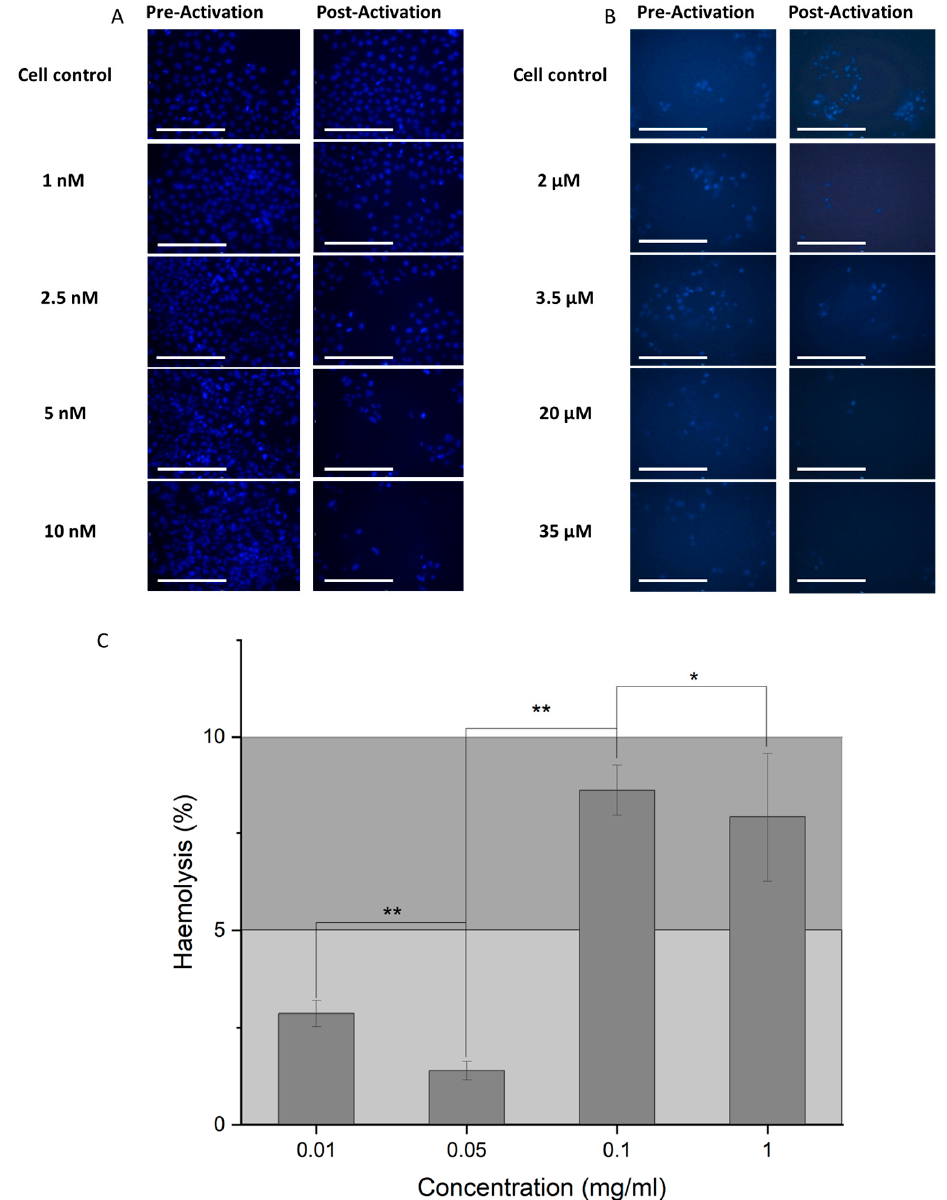
Figure 8. Visual demonstration of selective cell death by the stimulation of the NCC by radio waves. ( A ) RD cells and ( B ) U-87MG cells imaged under 495 nm light when stained with Hoechst, after treatment with pre-activation NCC (left), and post-activation NCC (right) at the following concentrations listed vertically downwards; ( A ) cell control, 1 nM, 2.5 nM, 5 nM, and 10 nM, and ( B ) cell control, 2 µ M, 3.5 µ M, 20 µ M, and 35 µ M. The scale bar is equal to 100 µ m. ( C ) The hemolysis percentages highlighting the biocompatibility of the unloaded NCC. PBS was used as a negative control and water as a positive control to indicate hemolysis. Negligible hemolysis is observed for concentrations from 0.01 to 1 mg/mL ION–polymer. p -values assessed are represented as follows ** = 0.05 < p > 0.01, * = 0.5 < p > 0.05. Bars represent mean +/ − standard deviation, n =